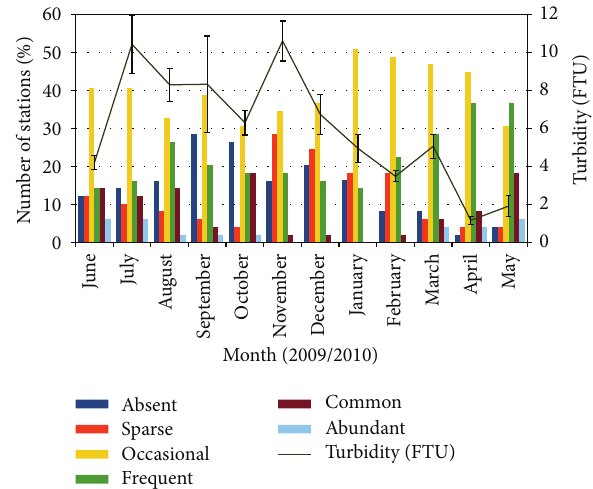
Figure 7: Monthly variations of grouped seagrass percentage cover and turbidity (FTU) ± S.E.